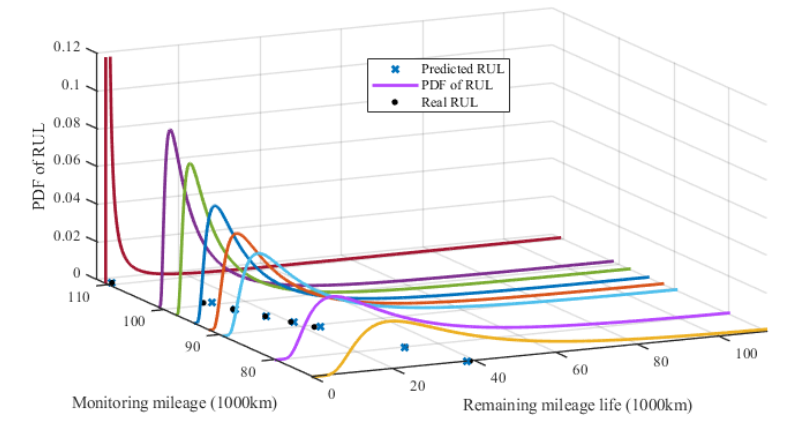
Figure 16. The PDF of RUL prediction.